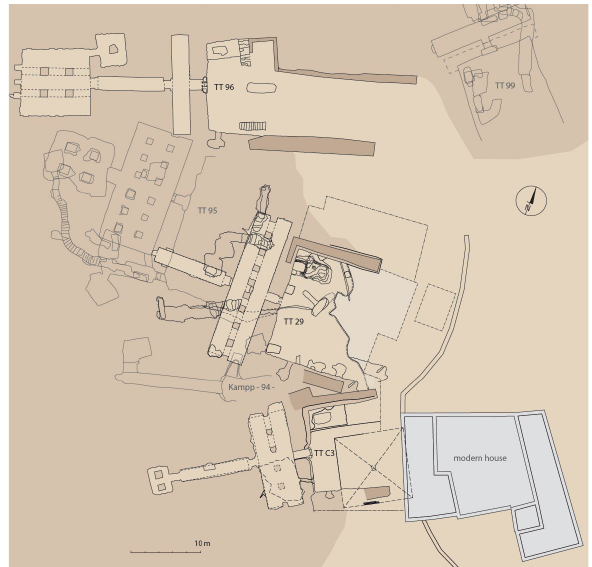
Figure 1 . Spatial localization of TT96 and TT29 (from Bavay, Laboury,